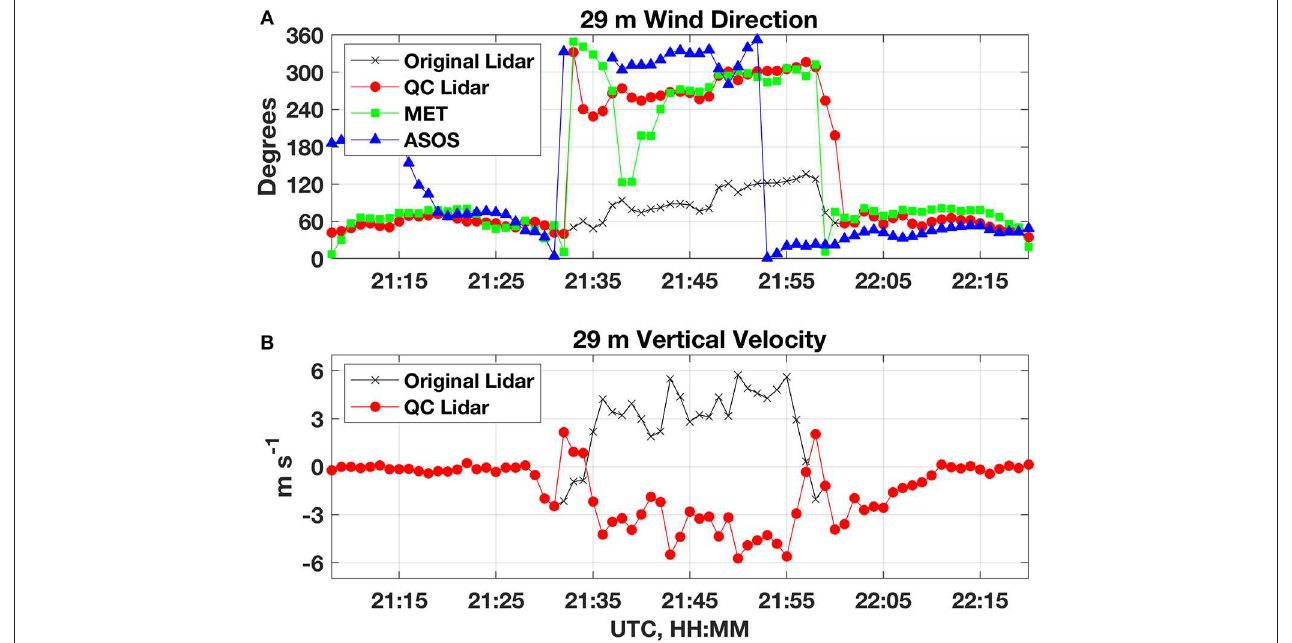
FIGURE 1 | Comparison of (A) corrected, quality controlled (QC) lidar, ASOS, surface MET station, and non-quality controlled lidar wind direction for the 3 July 2017 dataset (B) corrected and non-corrected lidar vertical velocities from the same